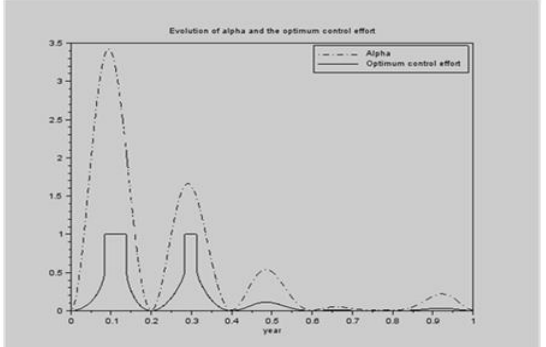
Fig1 : Optimum control effort over a one-year period θ 0 = 0 . 2 , θ 1 = 1 − 0 . 4 .